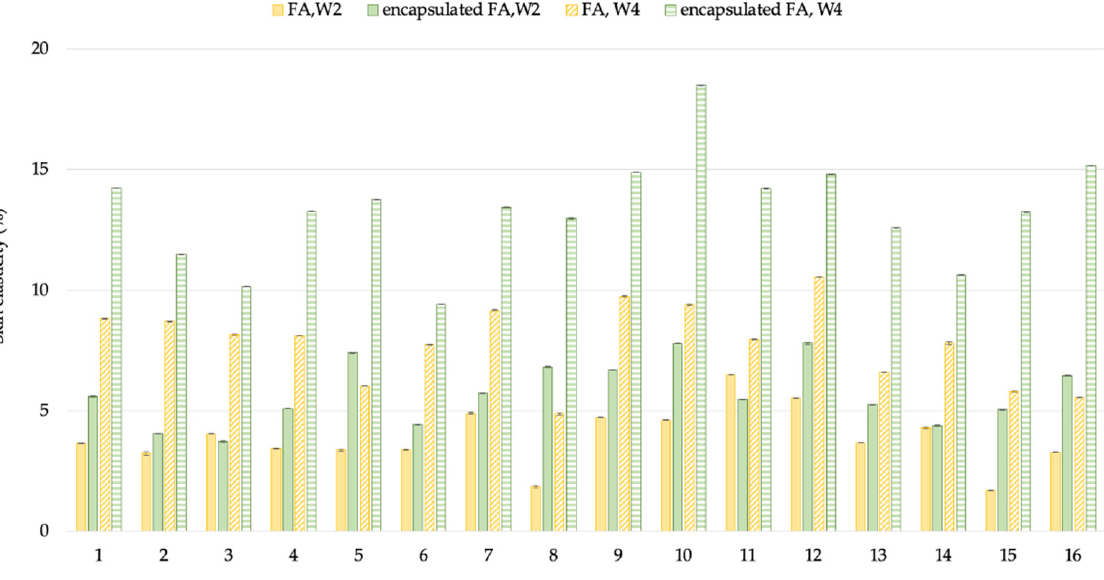
Figure 11. Percent of change in skin elasticity (R5) of each volunteer after application of FA and encapsulated FA creams for 2 and 4 weeks.